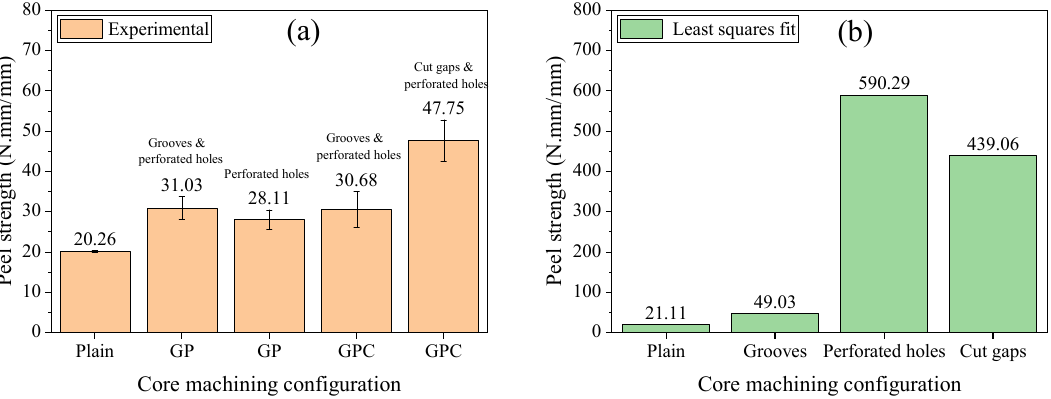
Figure 11. The peel strength of the cores: ( a ) the plain, GP, and GPC machining configurations and ( b ) the individual core machining configuration.